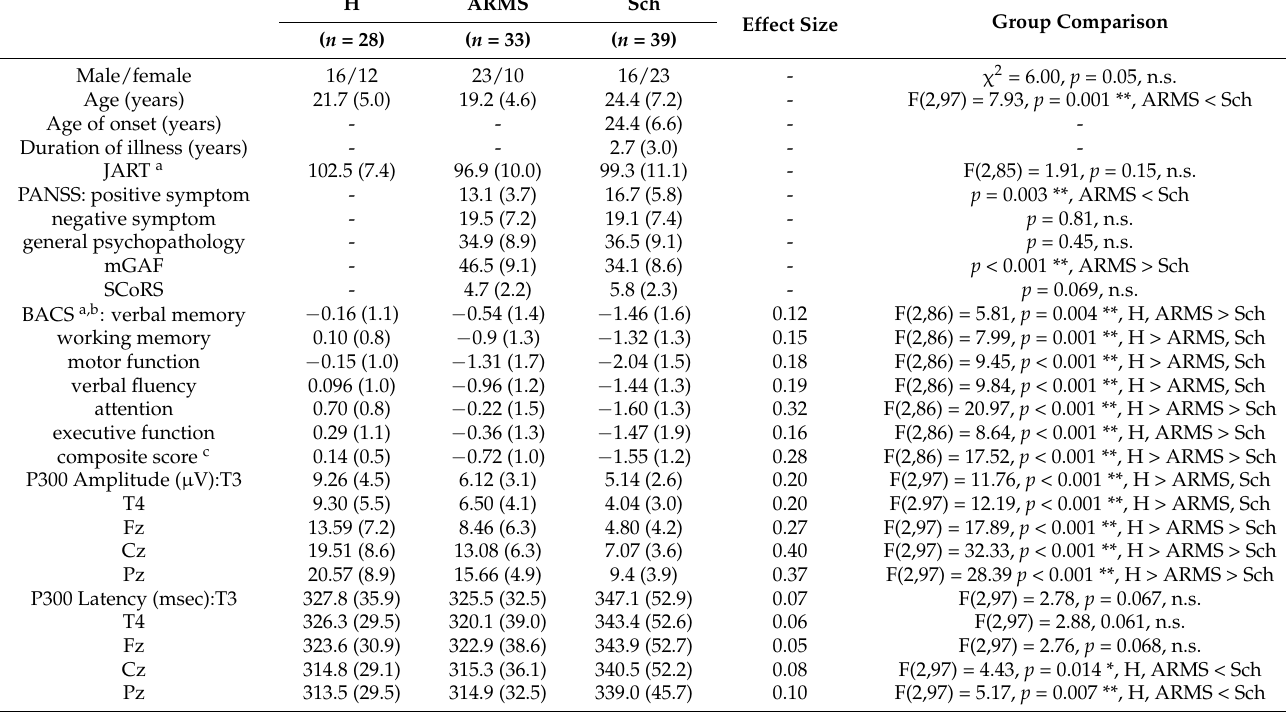
Table 1. Demographic data, cognitive functions and P300 parameters H ARMS Sch